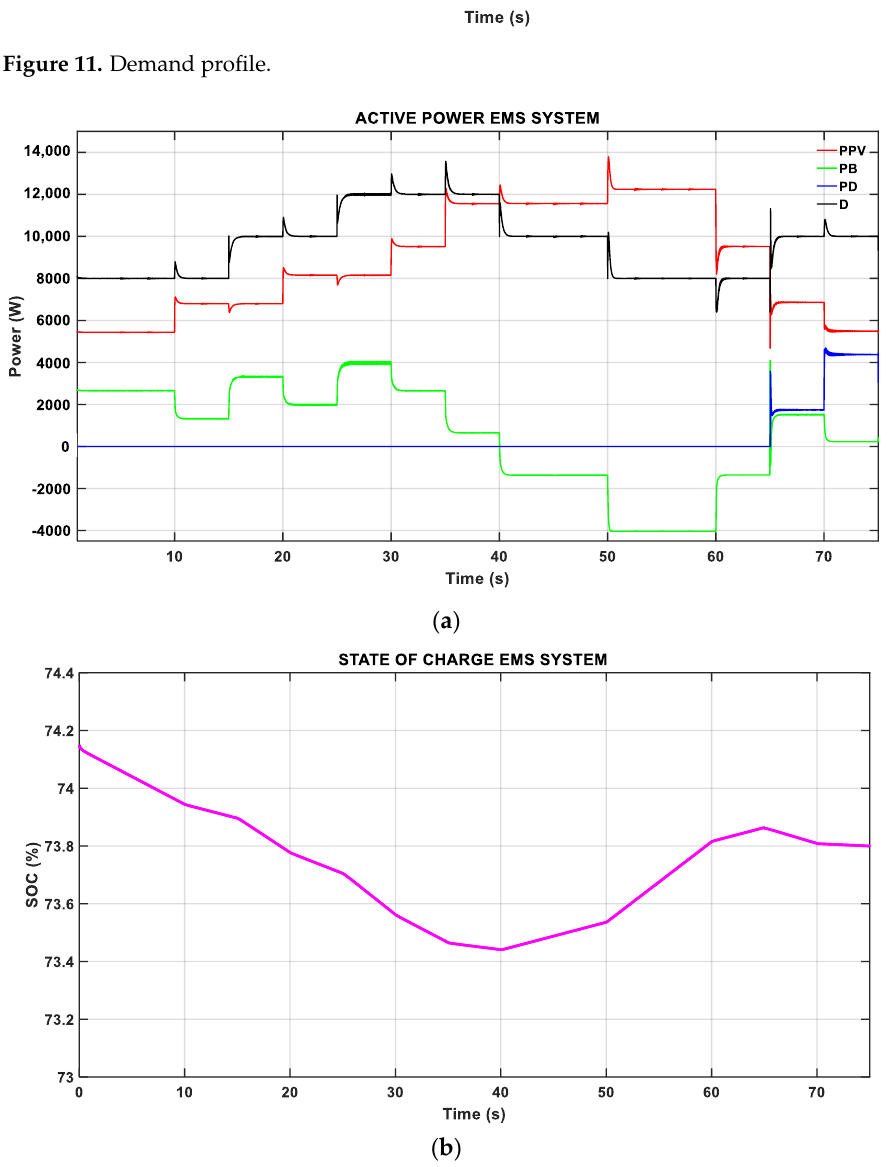
Figure 12. Microgrid performance with EMS; ( a ) Active Power Microgrid, ( b ) SOC of BESS.